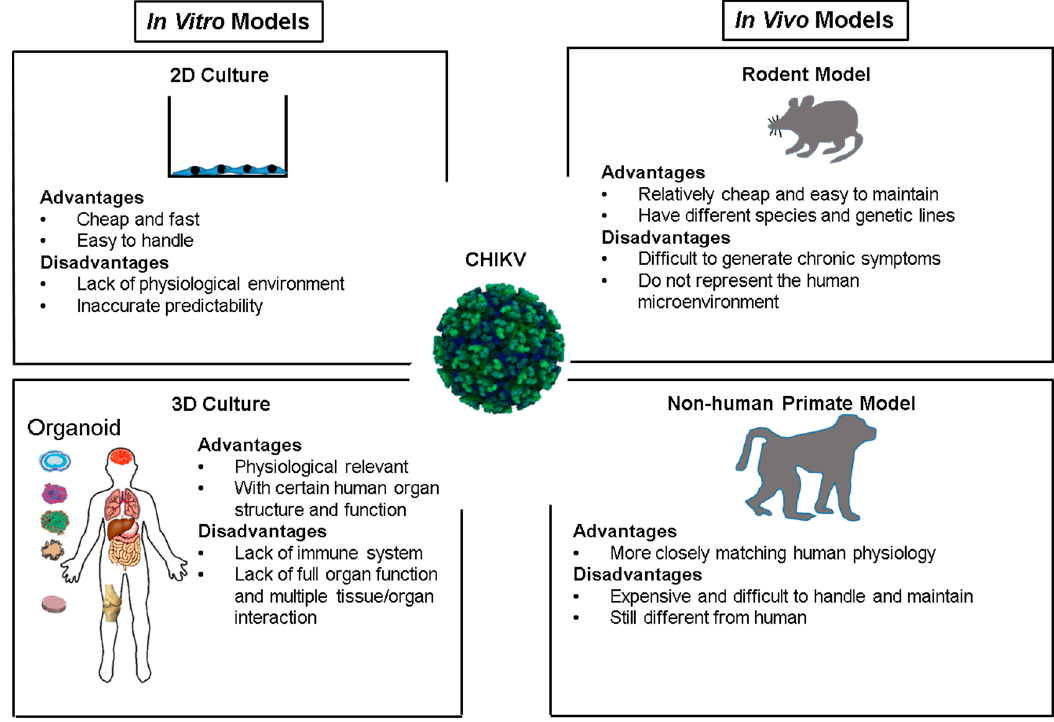
Figure 1. CHIKV in vitro and in vivo models. A comparison of the available infection models to study CHIKV pathogenesis, including advantages and disadvantages for each system. Of note, the 3D culture system has not yet been used as an infection model to study CHIKV infection.